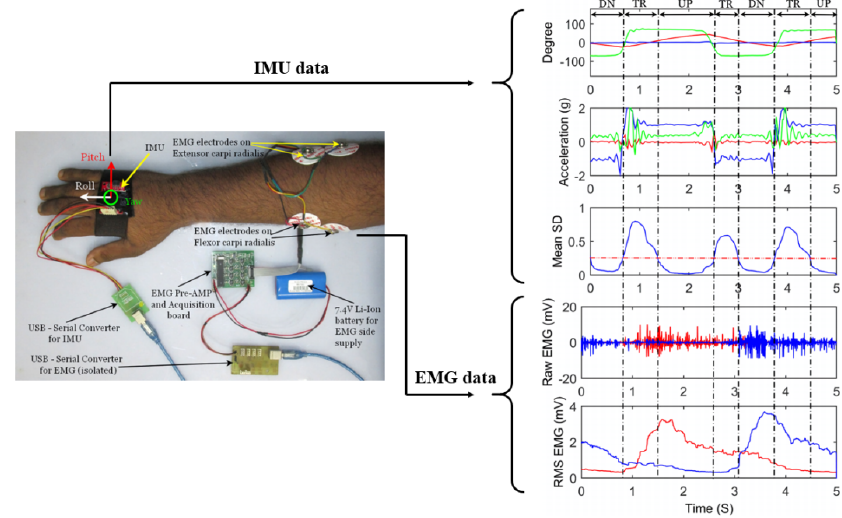
Figure 8. The fusion strategy of combining kinematics data (IMU) and EMG data, adopted from [112] .